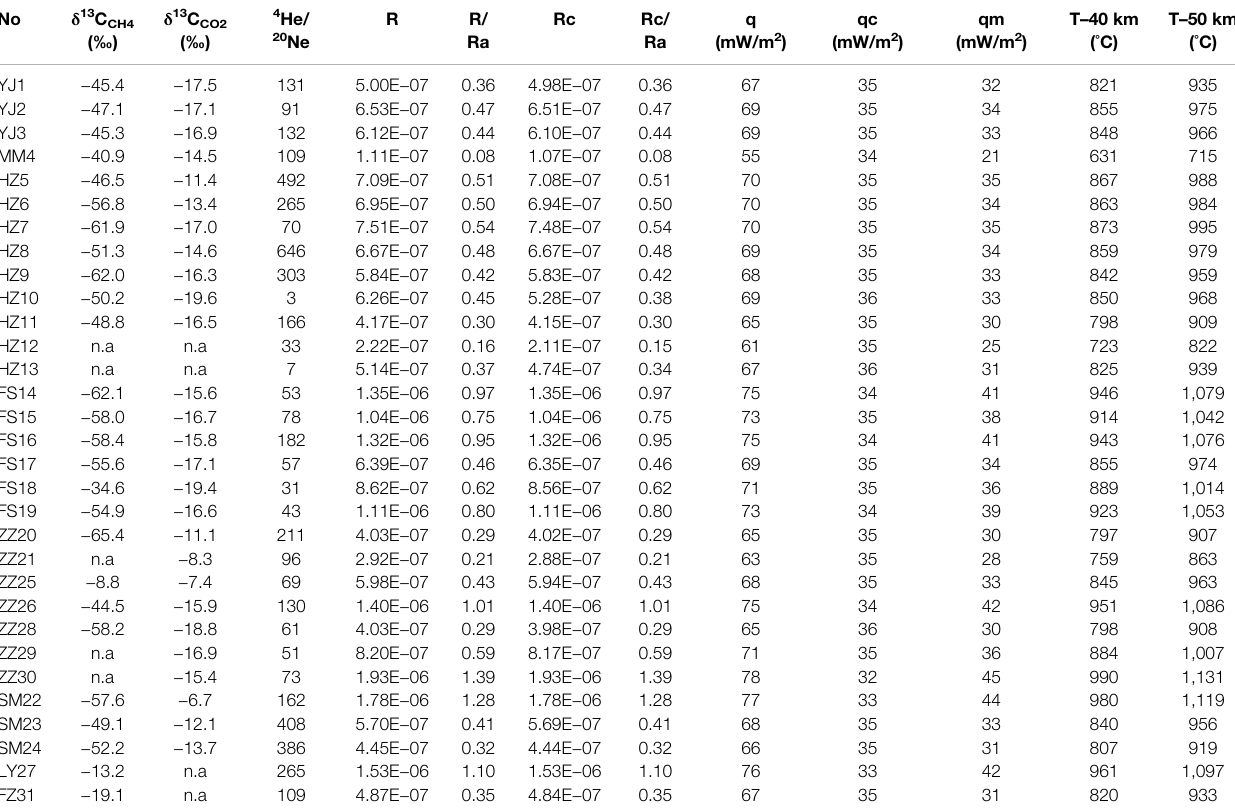
TABLE 2 | Isotopic composition of hydrothermal volatiles in this study area ( “ n.a. ” represents no